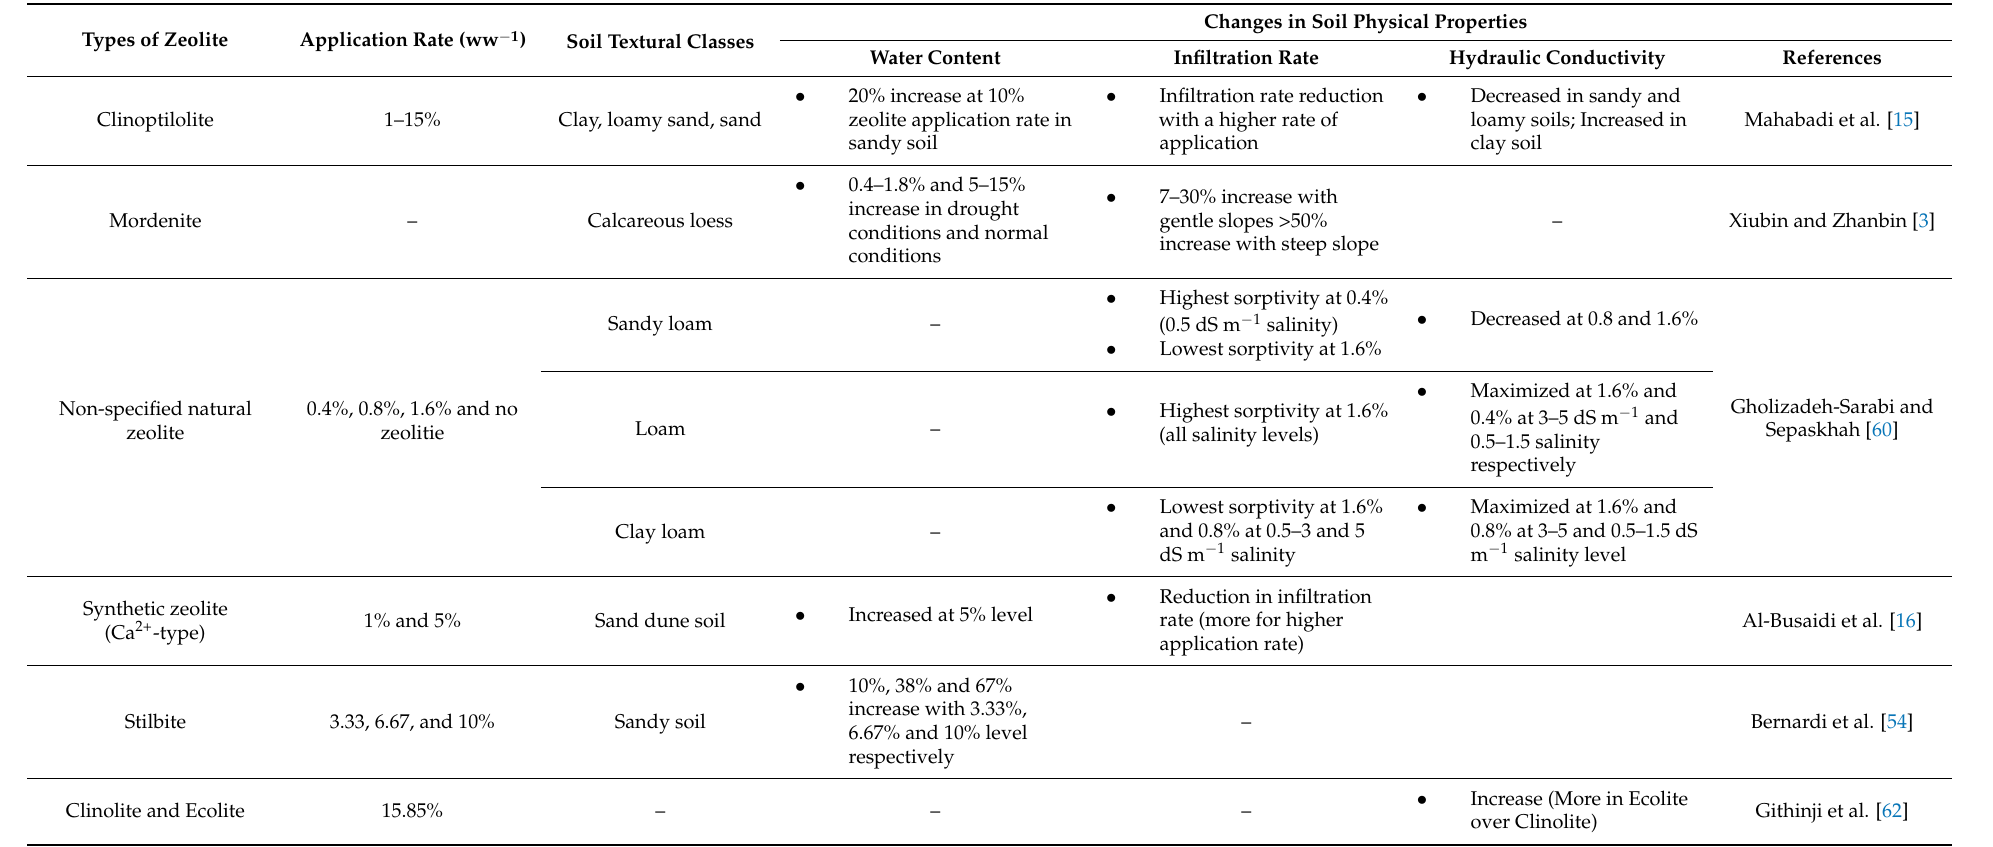
Table 2. Physical Properties of Soils as Influenced by Zeolites